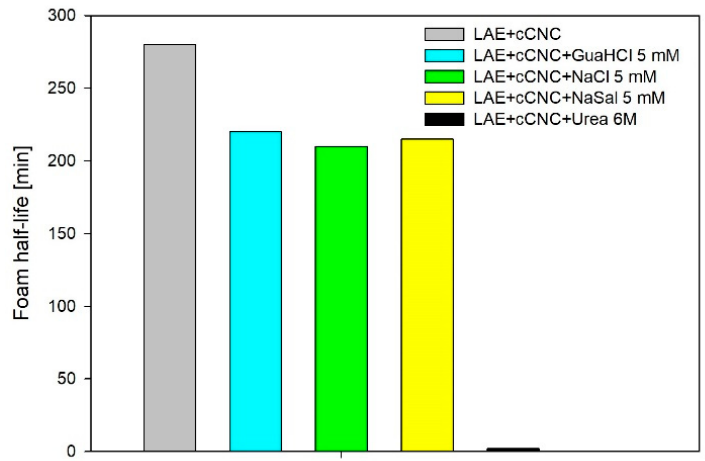
Figure 3. Foam half-life in the dispersion of LAE 0.006 wt.% and cCNC 0.3 wt.% with the addition of NaCl, NaSal, GuaHCl and urea.